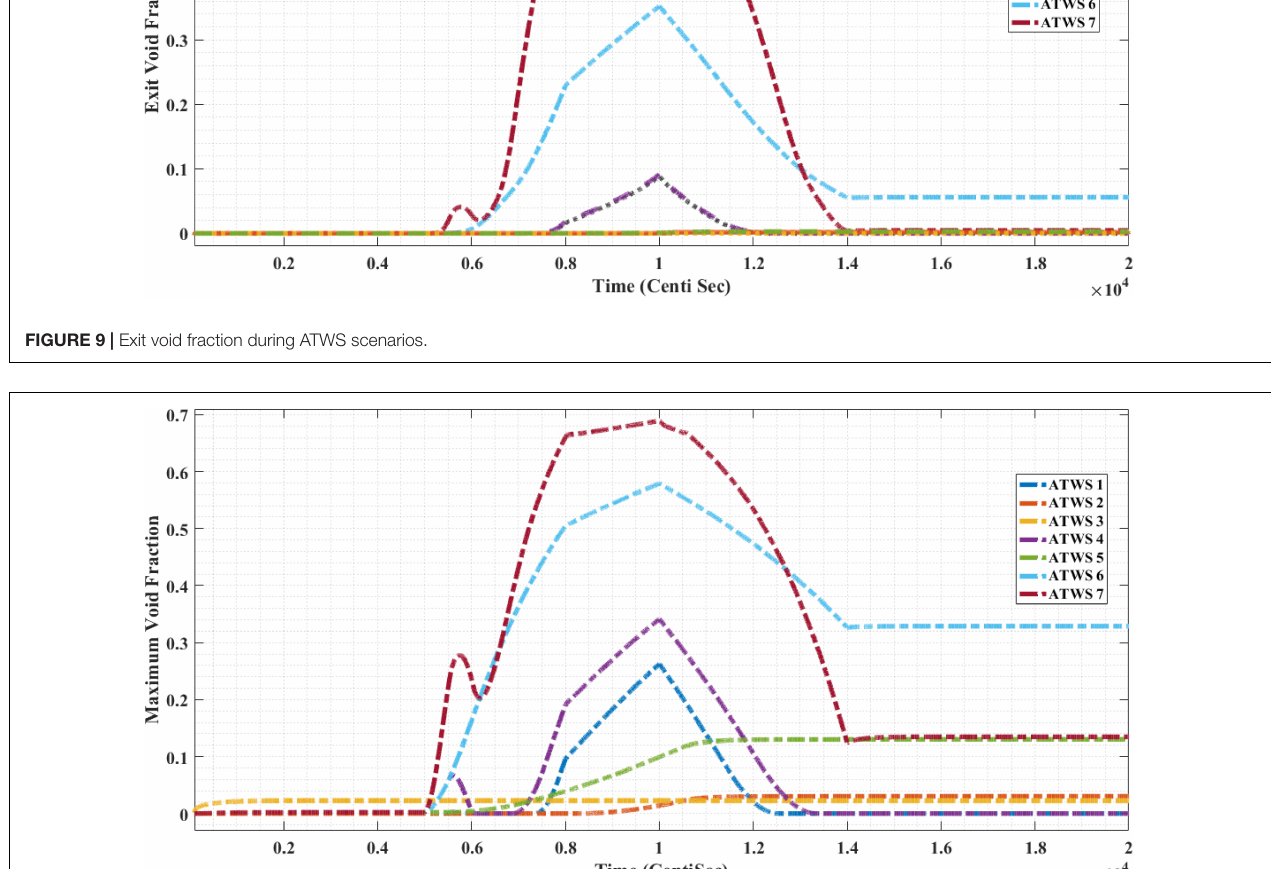
FIGURE 10 | Maximum void fraction during ATWS